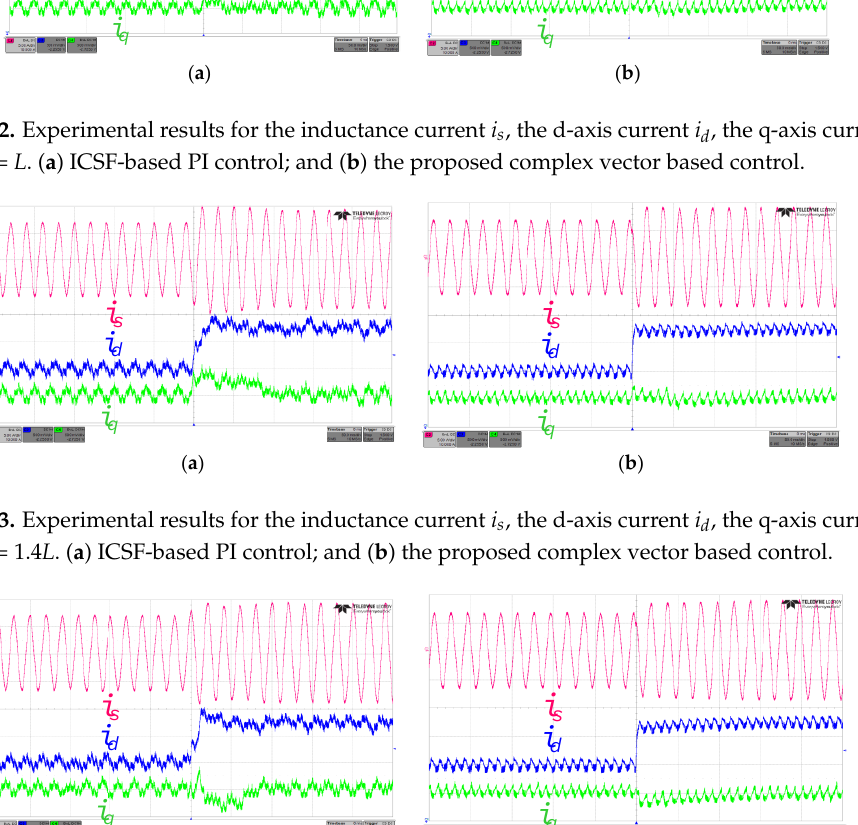
Figure 14. Experimental results for the inductance current i s , the d-axis current i d , the q-axis current i q when 𝐿̂ = 0.6 L . ( a ) ICSF based PI control; and ( b ) the proposed complex vector based control.